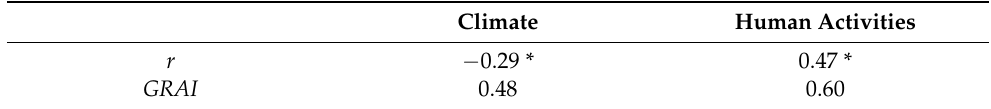
Table 7. Pearson correlation coefficient ( r ) and gray relational degree index ( GRAI ) between WER and climate, and WER and human activities nationwide.